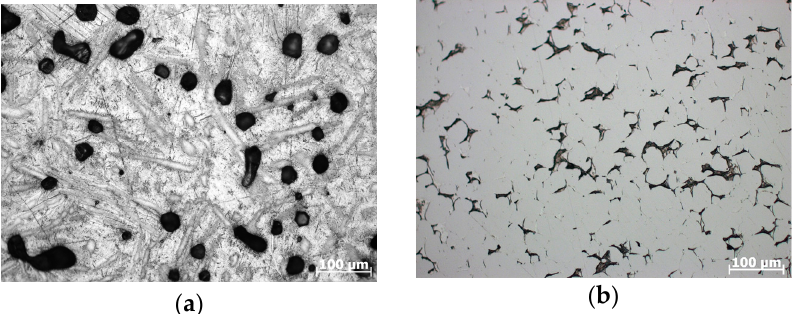
Figure 3. Microstructure of titanium powder: ( a ) TiC-50% Ti synthesized powder before sintering at 1350 °C; ( b ) after sintering at 1350 °C.